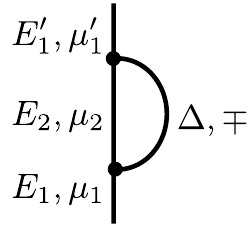
(cid:2)(cid:10) (cid:11)(cid:3) ^ O ^ O I . (cid:1) I E 2 (cid:1) I E 1 E 0 1